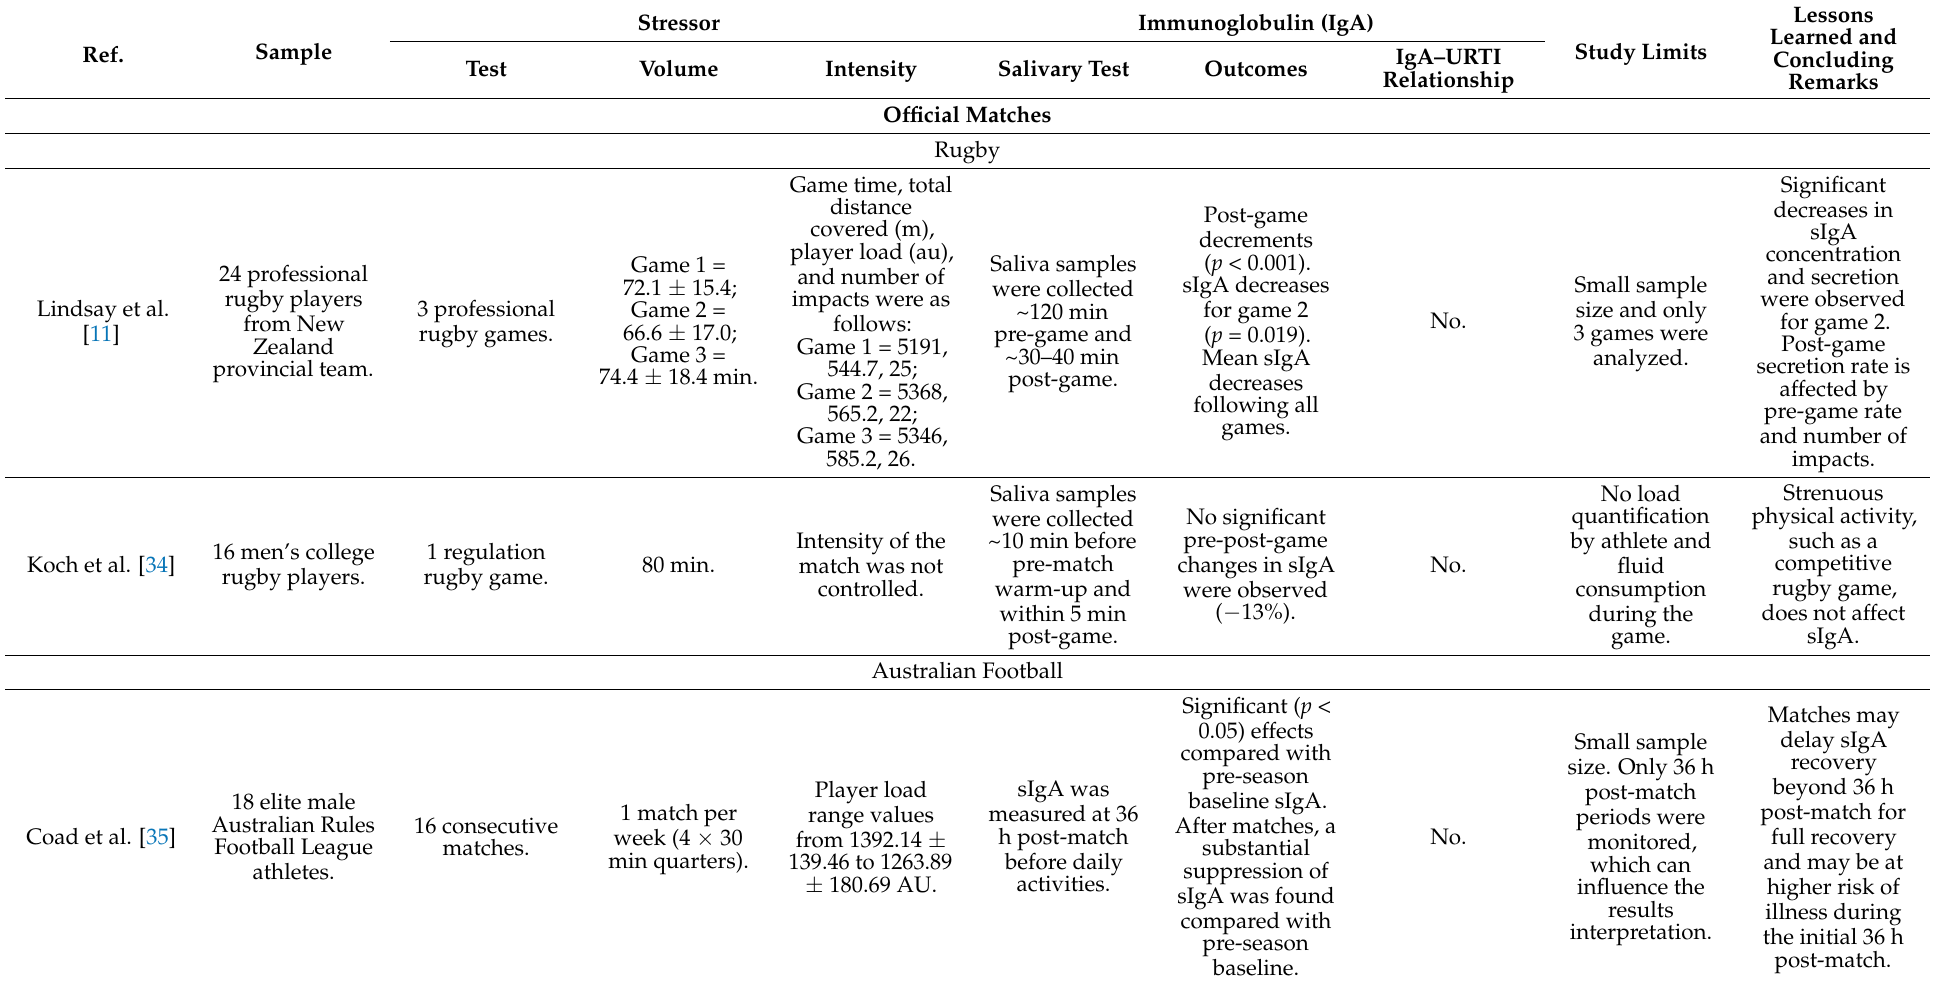
Table 3. Immunoglobulin A responses after match load and its relationship with upper respiratory tract infection